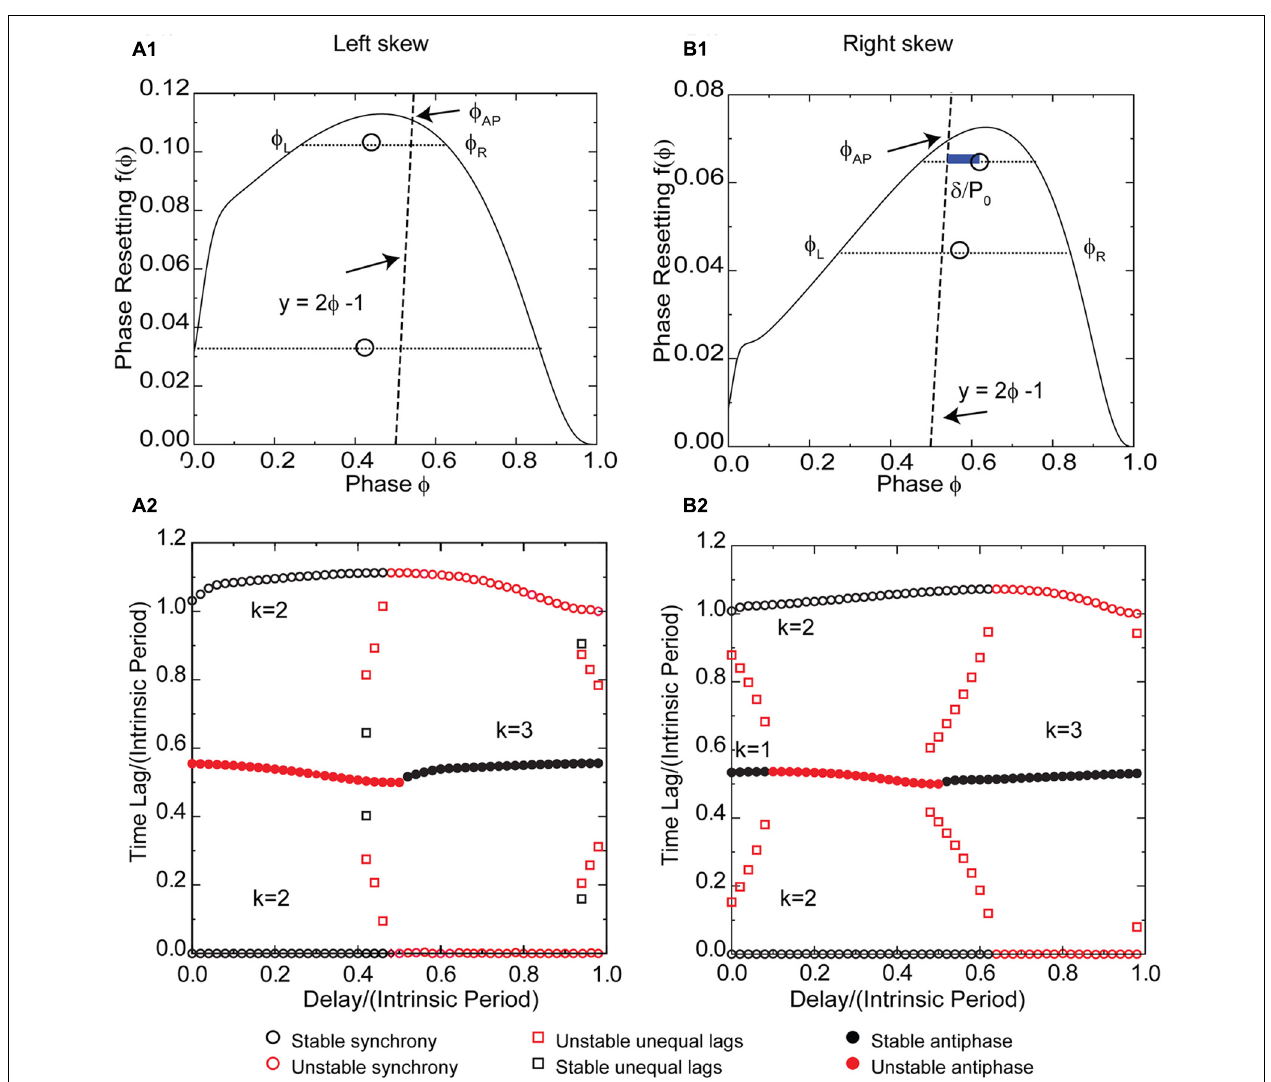
antiphase because the two time lags are equal, indicated by a filled symbol. Synchrony is stable for delays less than about half the intrinsic period, and antiphase is stable for delays greater than half the intrinsic period. (B1) Type 1 Wang–Buzsaki model right skewed PRC with g syn = 0.06 mS/cm 2 and I stim = 1 μ A/ms, g K = 9 mS/cm 2 .The line y = 2 φ − 1 intersects the PRC on the stable left branch, so antiphase with zero delay is stable.The open circles that indicate the center between the two branches fall to the right of the dashed line, so there is an unequal time lag branch at short delays (red squares for k = 1 in B2 ), but it is unstable.The blue bar shows a delay that falls on this branch. (B2) Predicted solution structure as delays are varied for two neurons coupled via the PRC in (B1) . At the shortest delays, synchrony and antiphase are bistable.The basin of attraction for antiphase is large at zero delay but shrinks with increasing delay until antiphase loses stability.